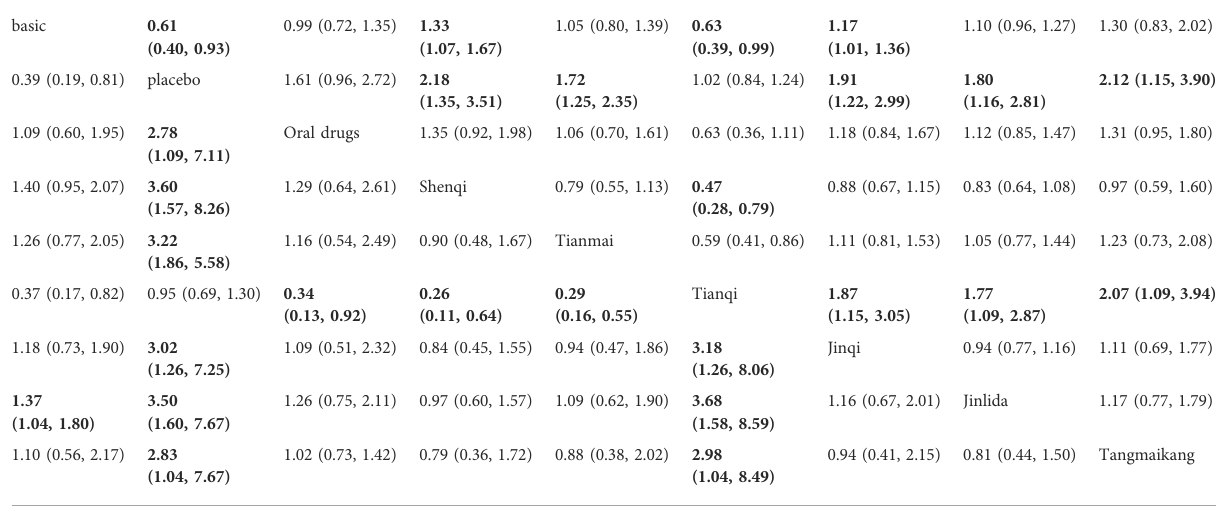
TABLE 4A The league table of Δ LDL-C and Δ HDL-C. Comparisons for Δ LDL-C (bottom left) and Δ HDL-C (upper right) of the 6